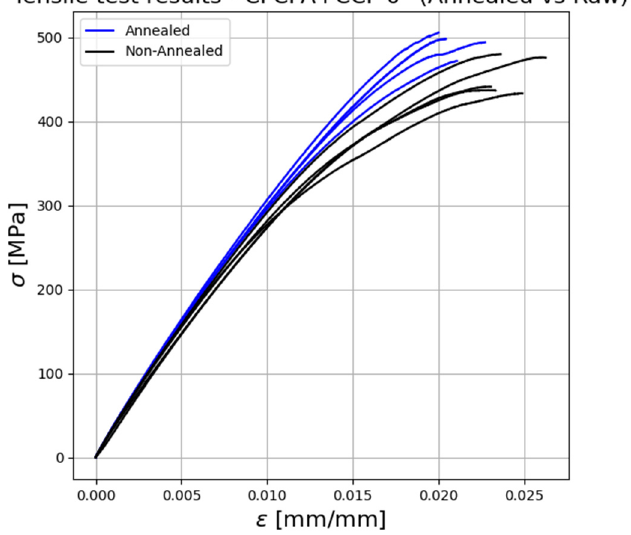
Figure 13. Stress–strain relationship of annealed and non-annealed continuous FRP (0°).